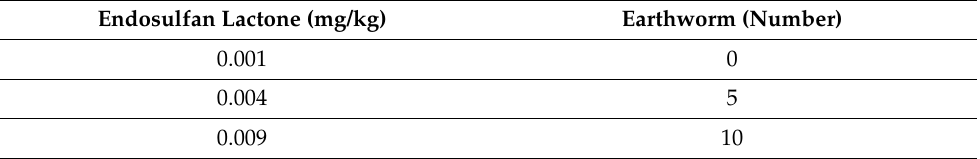
Table 1. Factors used in the optimization of endosulfan lactone